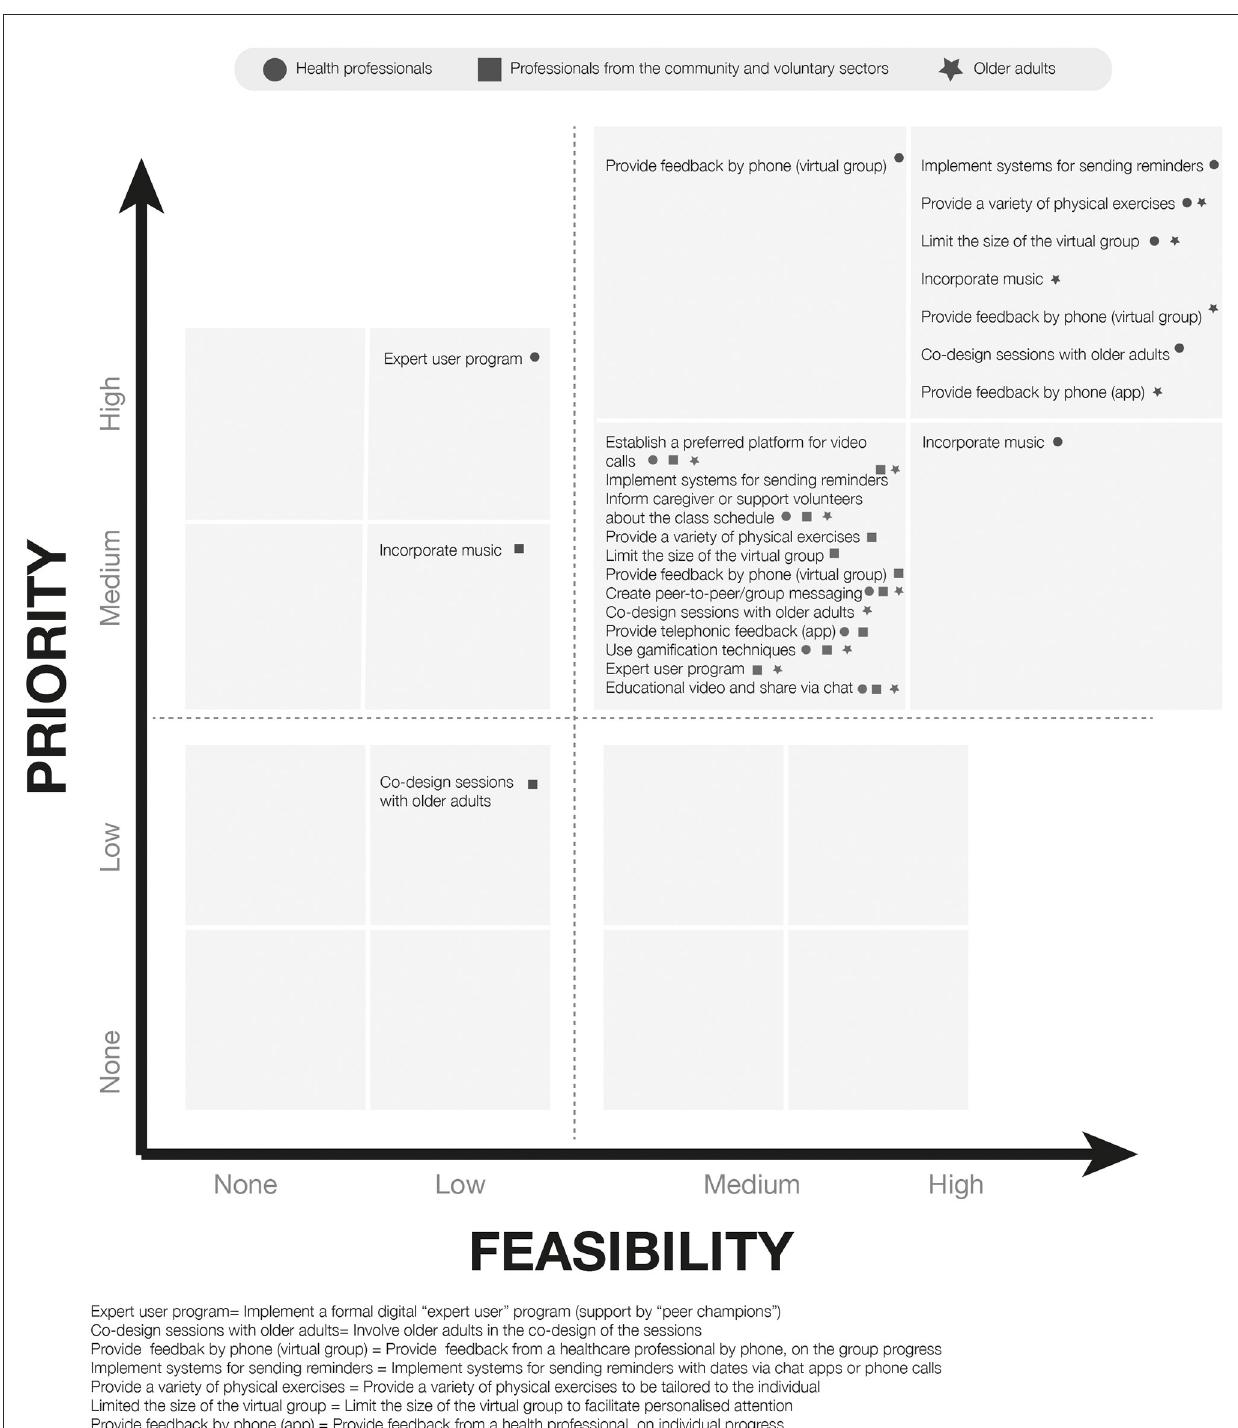
FIGURE2 Mapping of responses to specific strategies to facilitate the use of physical activity App and specific strategies to facilitate the participation of the older adults in virtual exercise groups performed at home during group video calls.